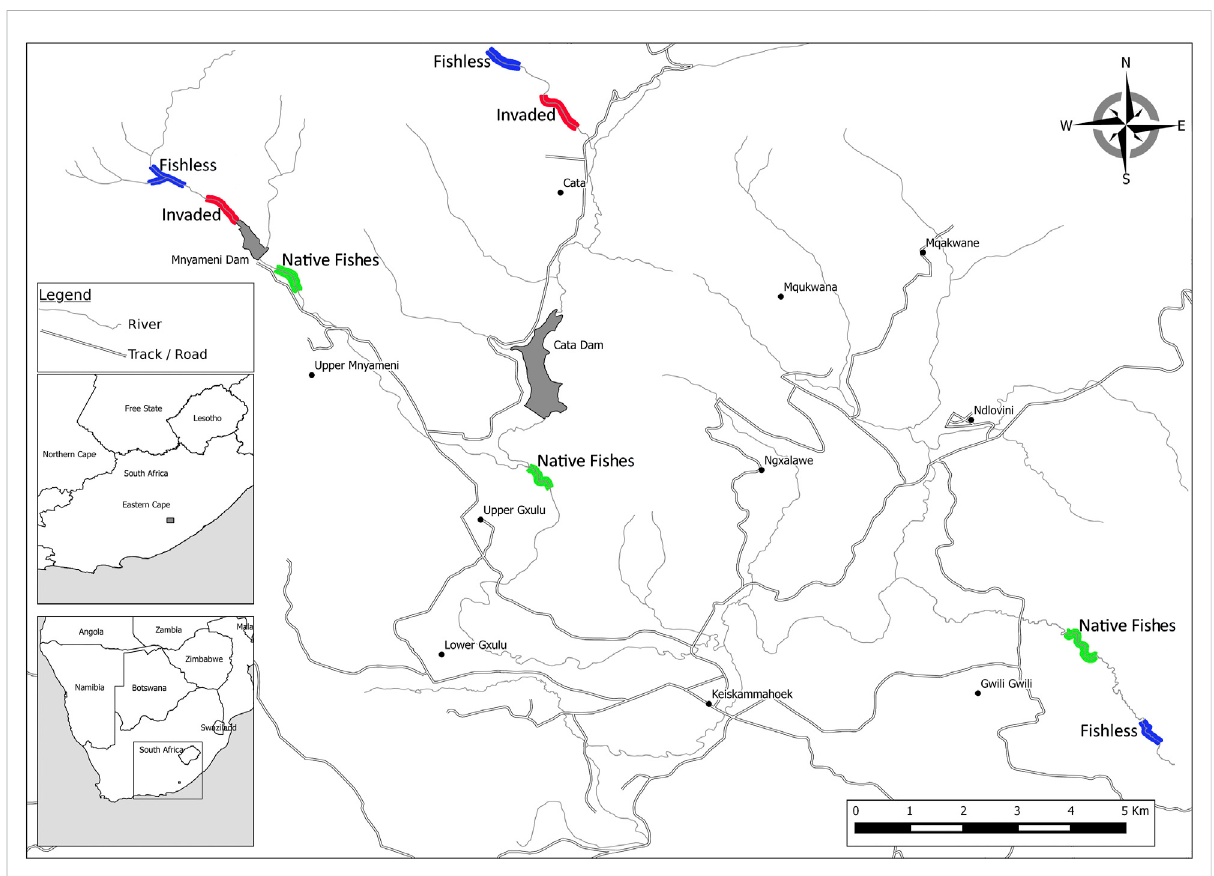
FIGURE 2 Map of the upper Keiskamma river system, Eastern Cape, South Africa, showing the distribution of sampling locations within reaches of stream that were fi shless (blue), invaded by non-native trout (red) and reaches containing native fi sh species (green) described by Ellender ’ s (2014) study of the system (modi fi ed from Ellender